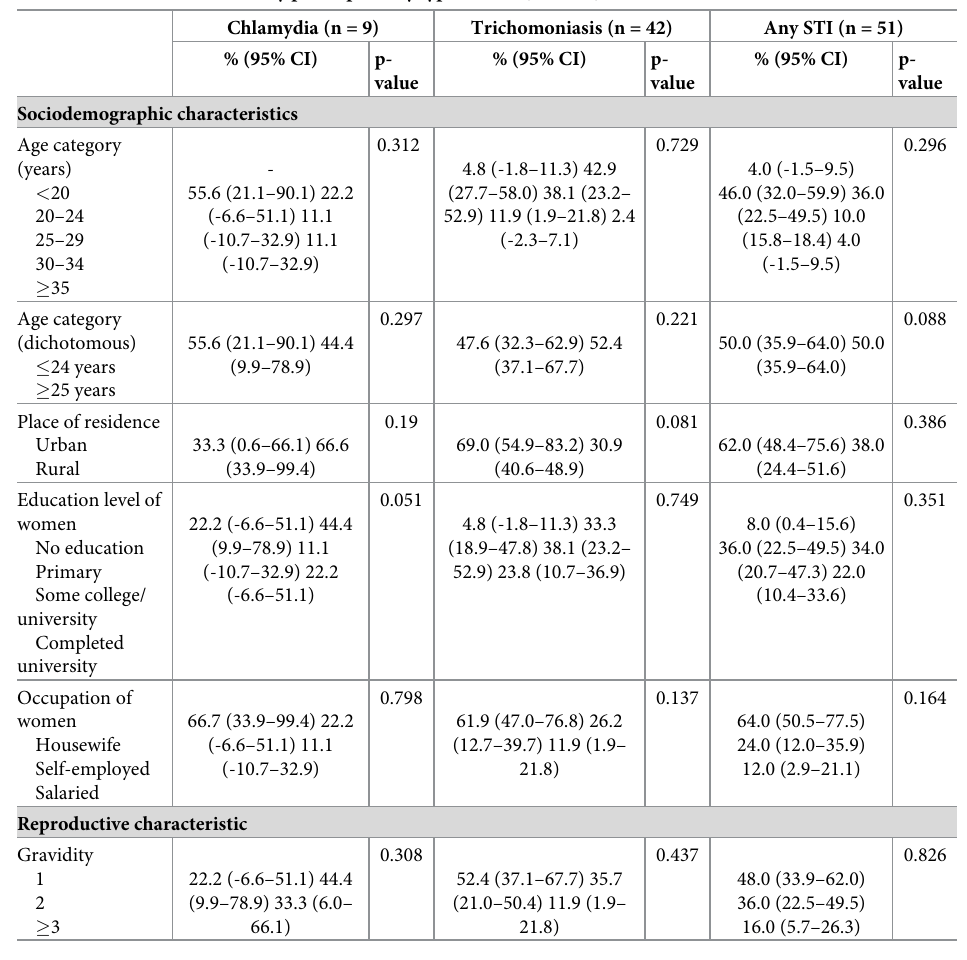
Table 3. Characteristics of study participants by types of STI (N =